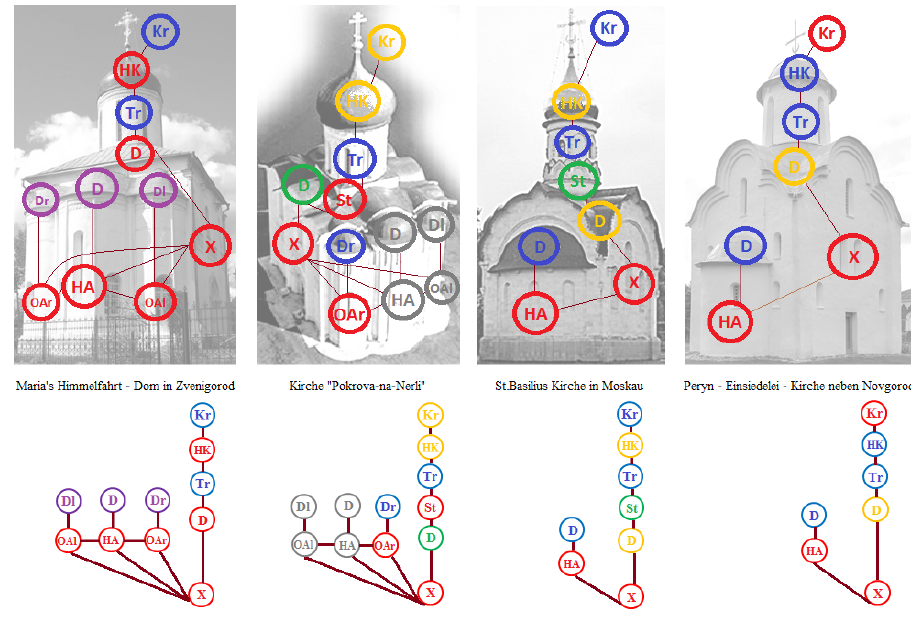
Figure 1: Church representation with colored